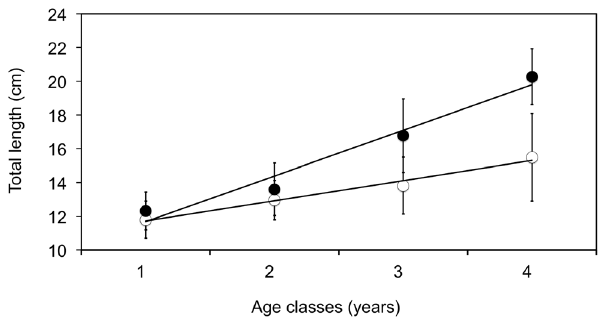
Figure 4. Relationship between total length (cm) and age (otolith based, years) of polar cod. Specimens from the Arctic (n=97, closed) and Atlantic (n=199, open) domains. Points indicate mean and wiskers are standard deviation, lines are predicted from a generalized linear model for the two domains where age was treated as a continuous variable. Arctic: TL=2.710 Age + 8.898 (R 2 =0.96)